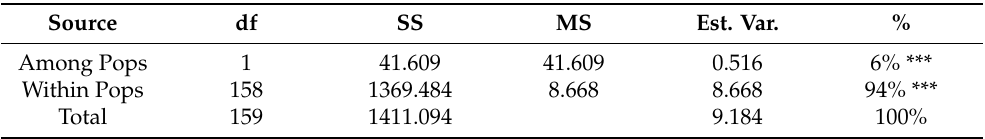
Table 4. Summary table of AMOVA result between clinical and environmental populations of C. tropicalis